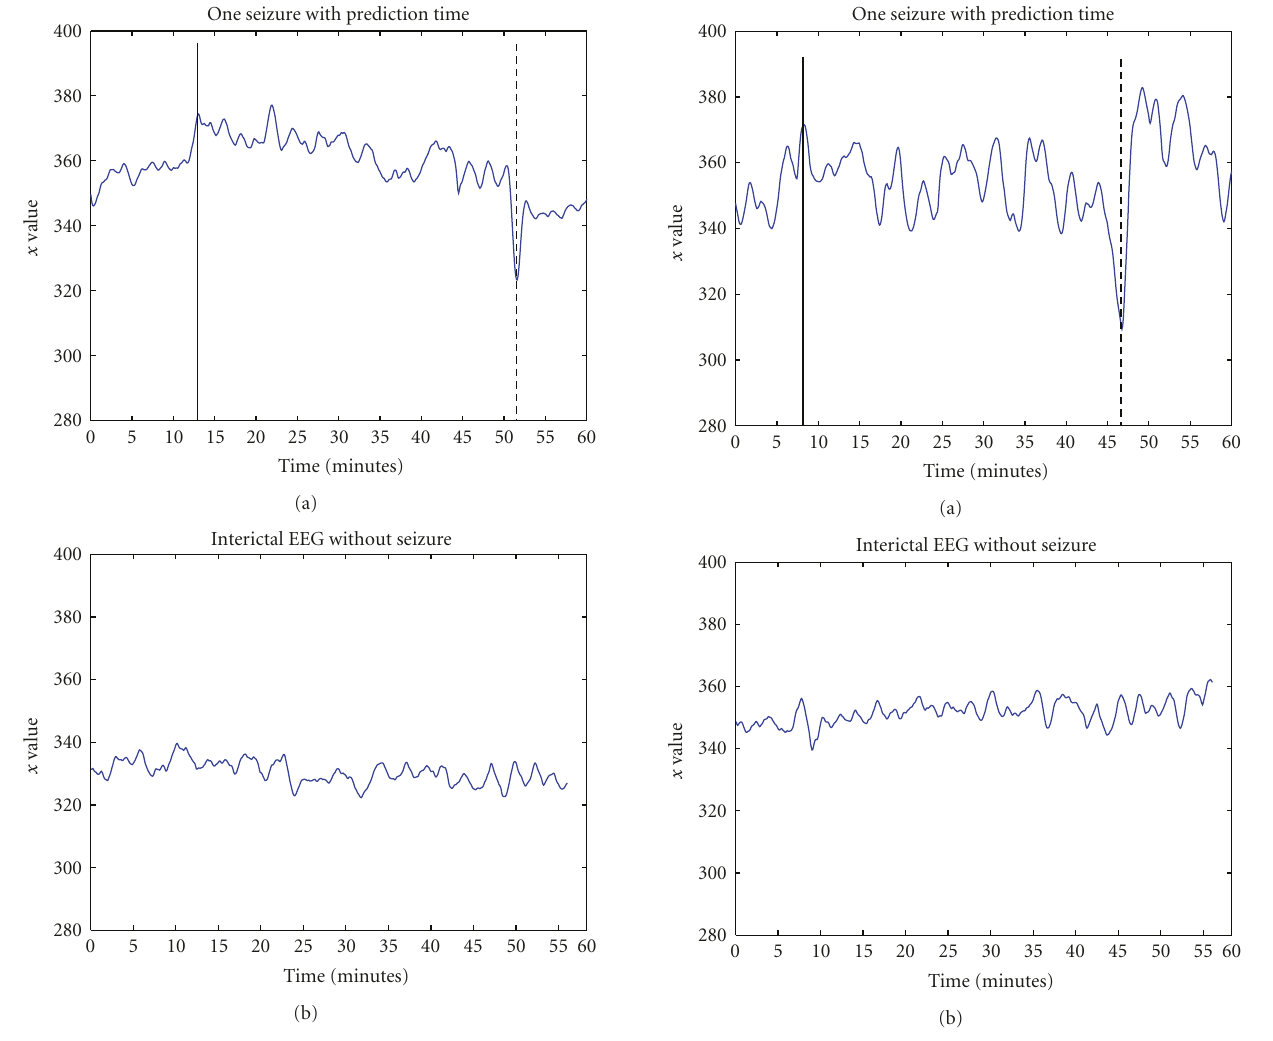
Figure 6: Ictal and interictal hidden variable x from one patient with epilepsy. The vertical solid line marks prediction time point and the vertical dashed line indicates seizure